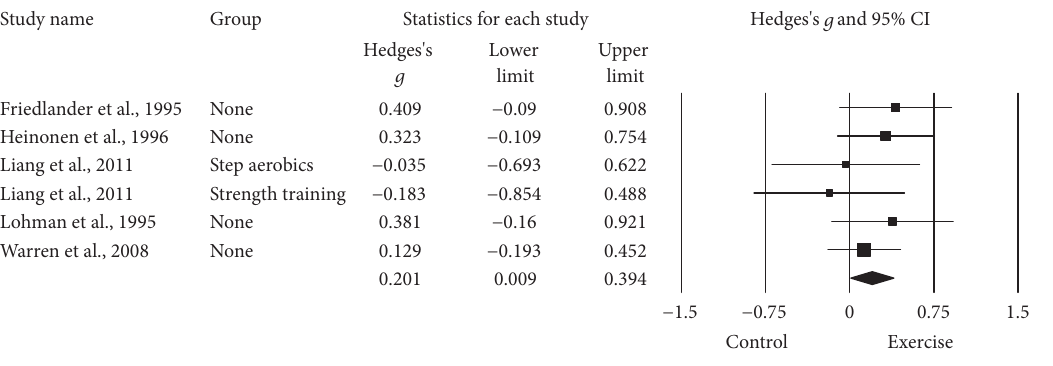
F 5: Forest plot for changes in LS BMD. Forest plot for point estimate standardized effect size changes ( represent the standardized mean difference ( intervals. e middle of the black diamond represents the overall standardized mean difference ( diamond represent the corresponding 95